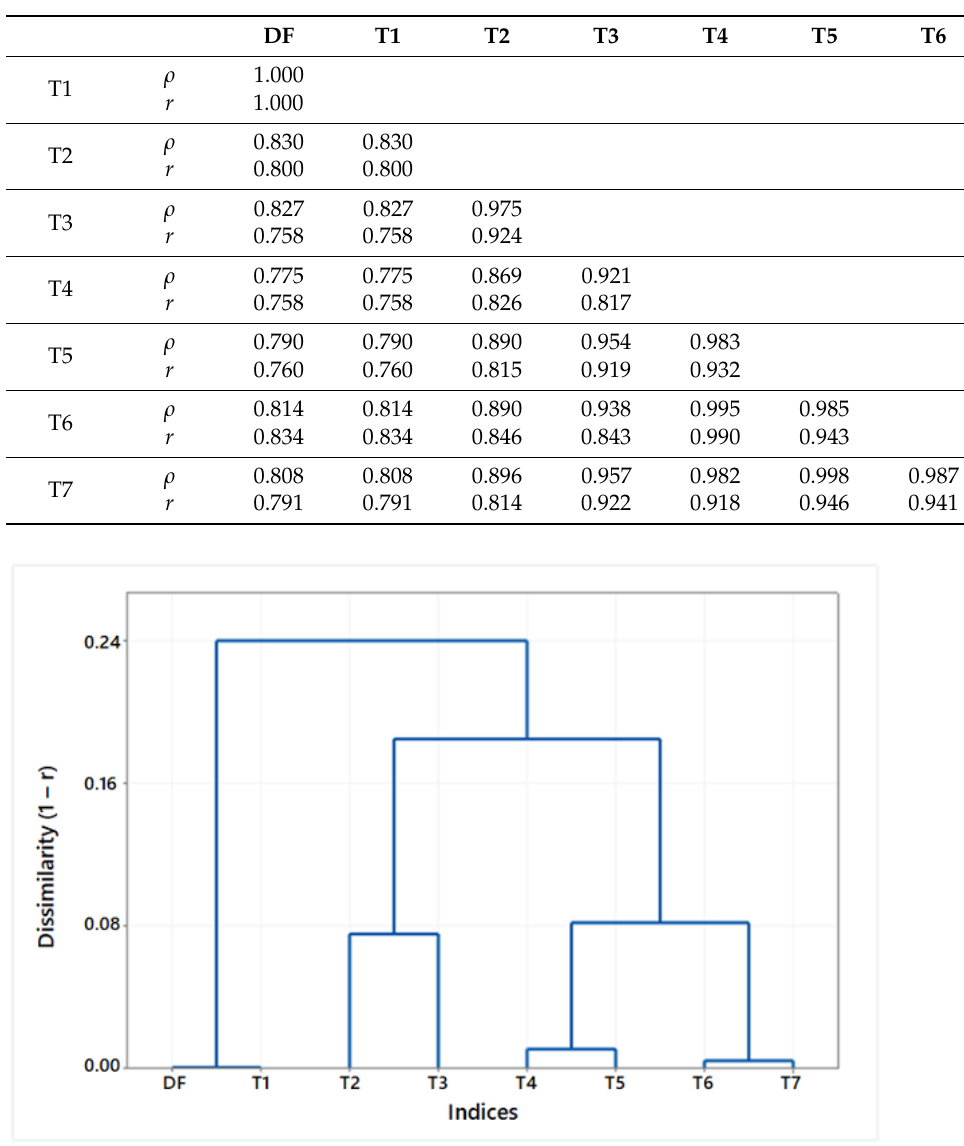
Figure 10. Dendrogram showing the dissimilarity (1 − r ) among tortuosity indices according to Pearson’s correlation coefficient and the resulting clusters.